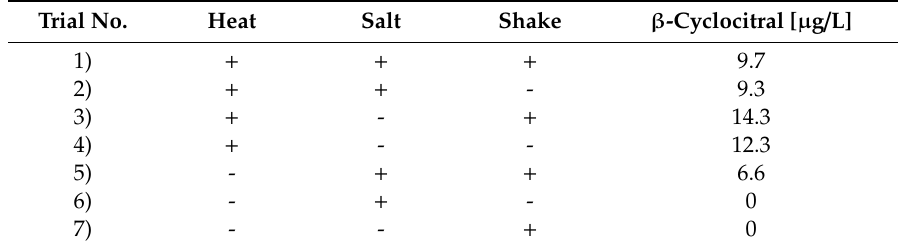
Table 2. Analysis results of β -cyclocitral from Microcystis aeruginosa NIES-843 using GC / MS with SPME by the appropriate combination of heating, salting out, and shaking ( n =